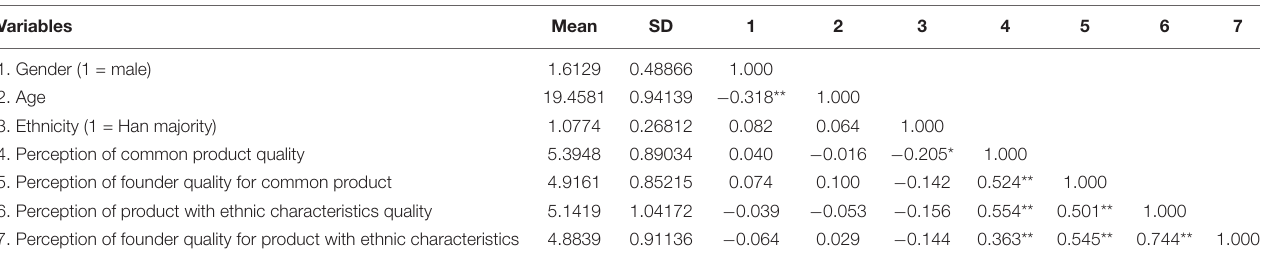
table of correlation results that the correlations of gender, age, ethnicity, perception of common product quality, perception of founder quality for common product, perception of product with ethnic characteristics quality, and perception of